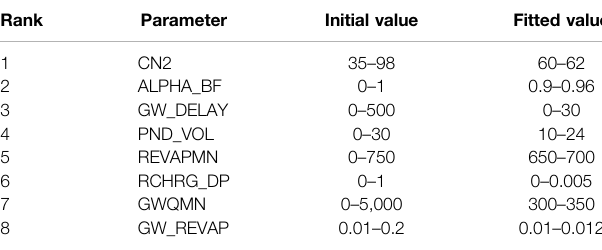
TABLE 2 | Parameter sensitivity ranking and parameter fi tted value